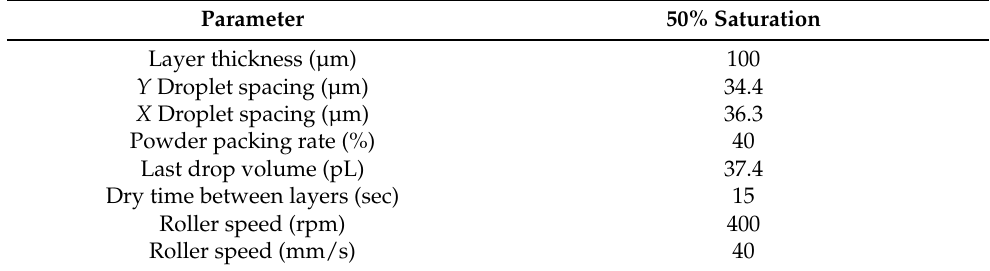
Table 2. Printing parameters for the SiC preform.